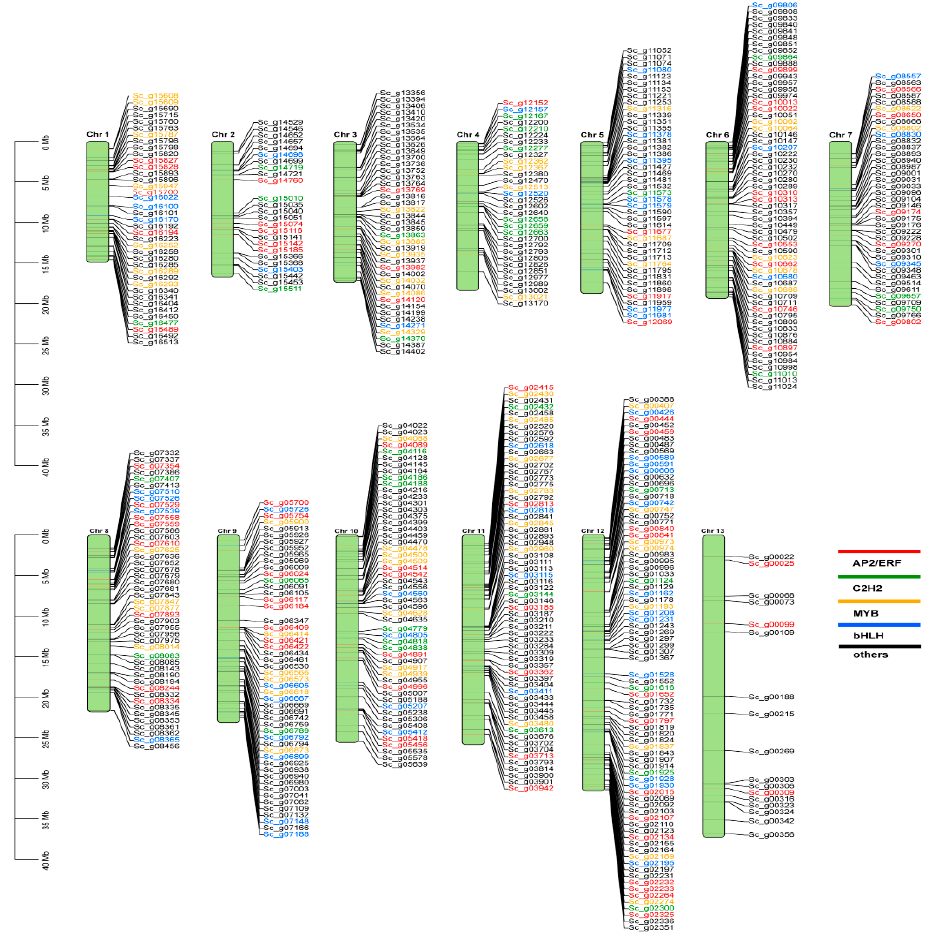
Figure 2. Chromosomal mapping of TF members on the S. caninervis genome based on their physical positions. The four most abundant TF families including, AP2/ERF, MYB, bHLH, C2H2, and others, were represented by different colors, such as red, green, orange, blue, and black, respectively.